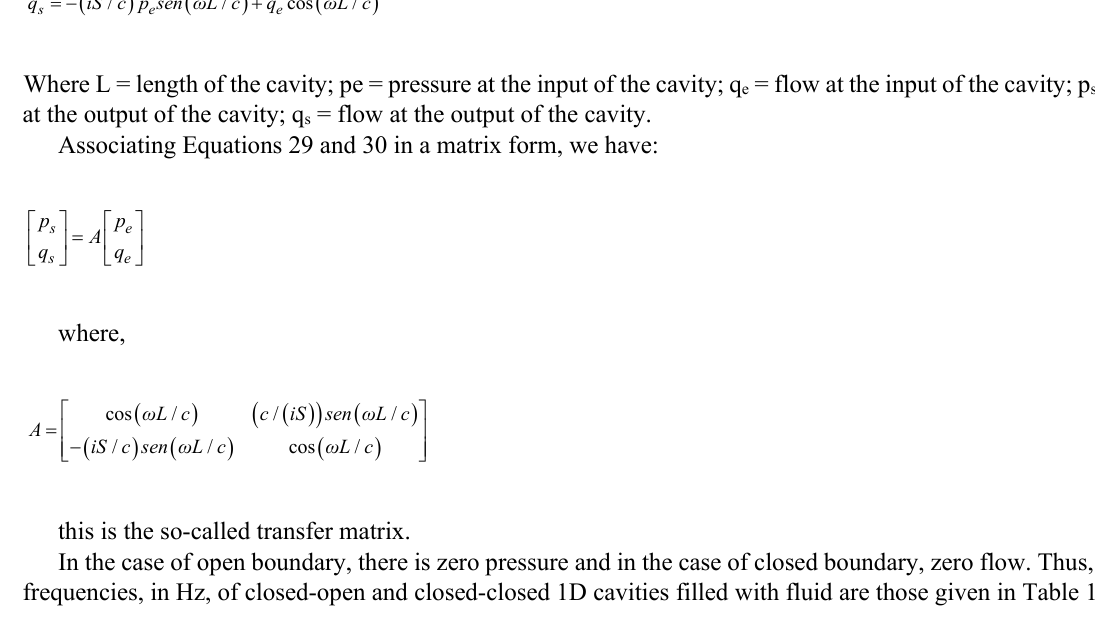
Table 1. Natural Frequency of Acoustic Cavities Cavity Natural Frequency, f ( Hz ) Cavity Natural Frequency, f ( Hz ) Closed-Open , , , ,... c = speed of sound; L = width of the